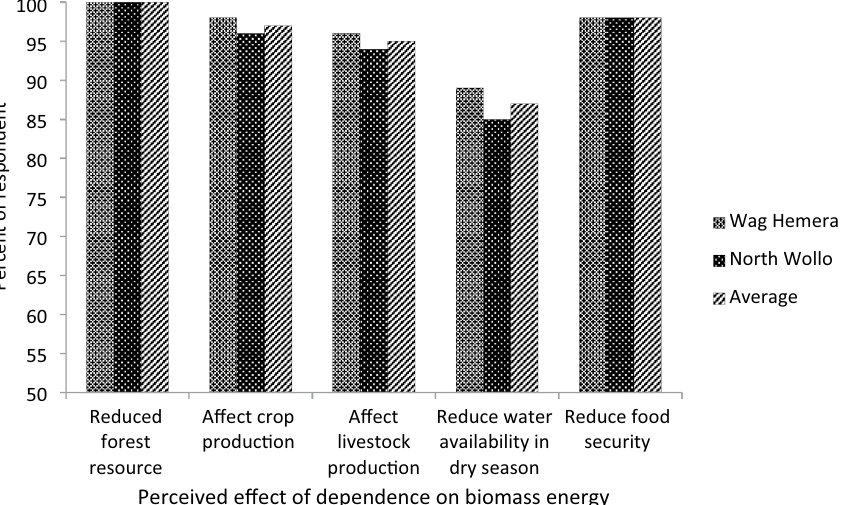
Figure 1. Perceived effects of household dependence on biomass for fuel in Wag Hemera and North Wollo zones, northern